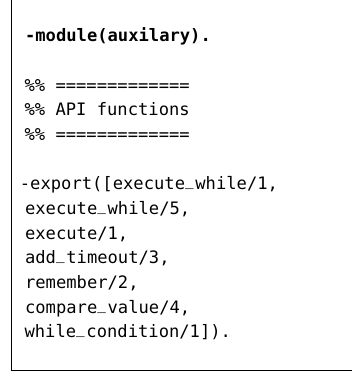
Table 13. API functions that work as an